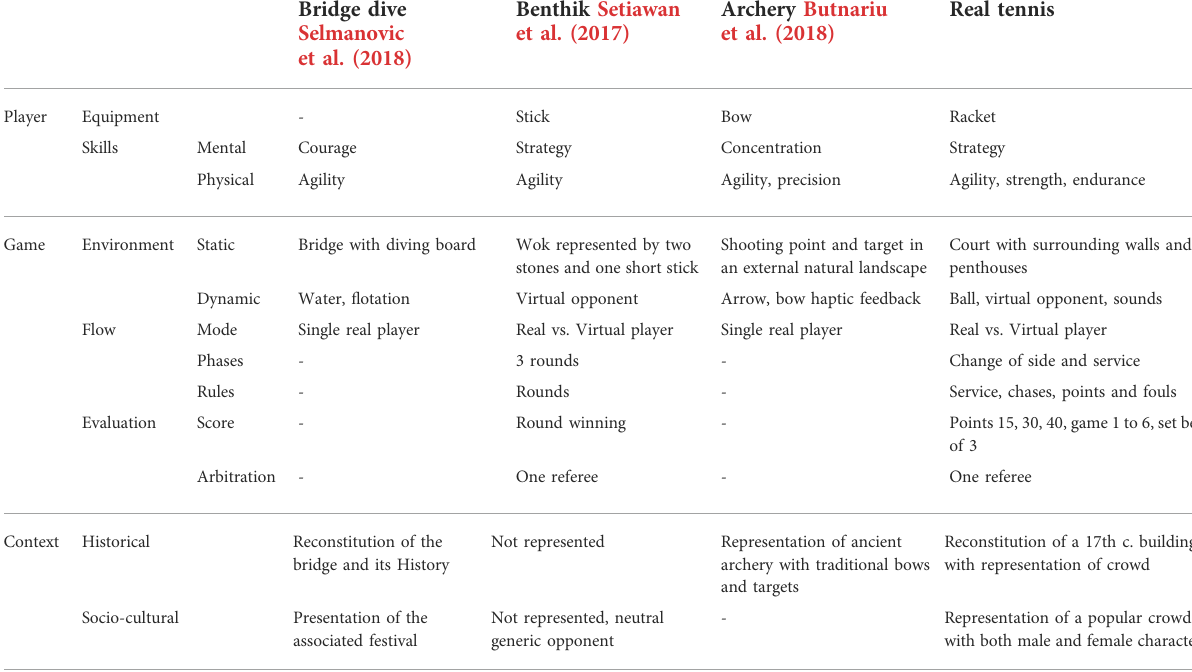
TABLE 1 Characteristics for Bridge dive, Benthik, Traditional archery, and real